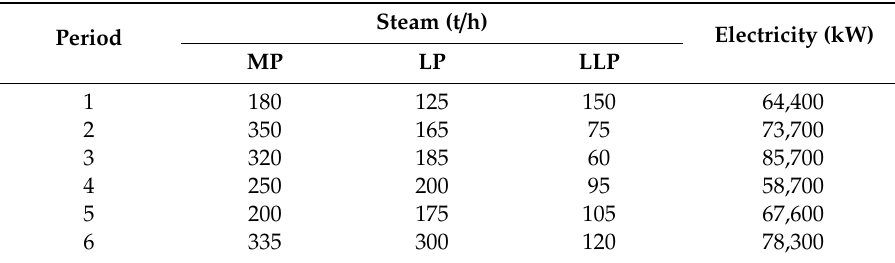
Table 12. Multi-period steam and electricity